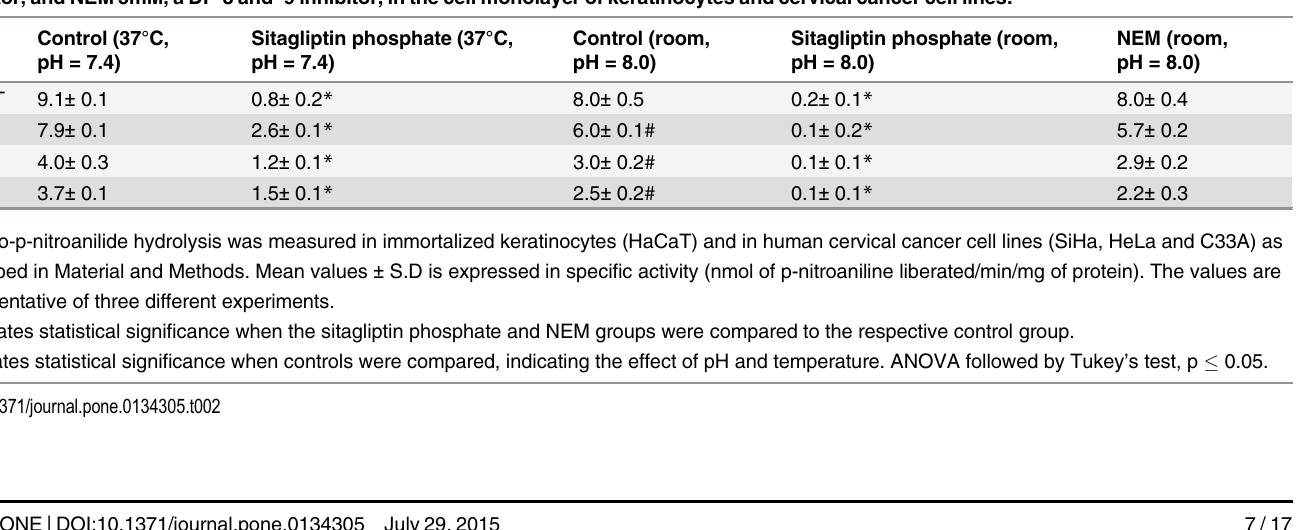
Control (room, Sitagliptin phosphate (room, pH = 8.0) pH = 8.0)